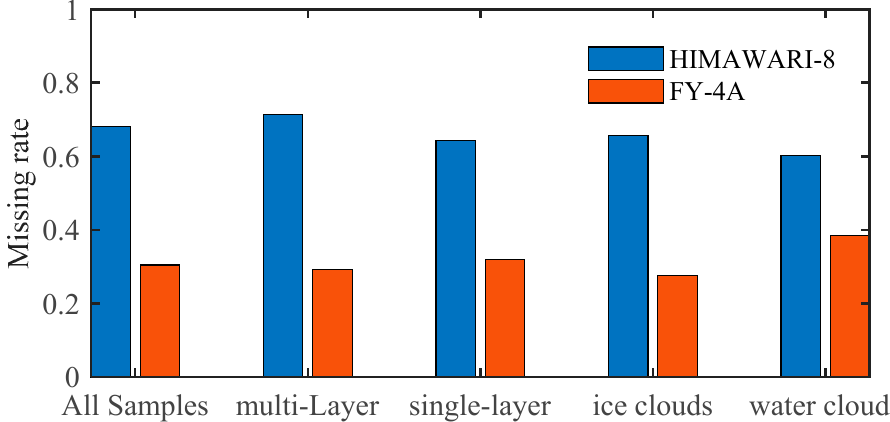
Figure 6. Missing rate of FY-4A and HIMWARI-8 in different scenarios.